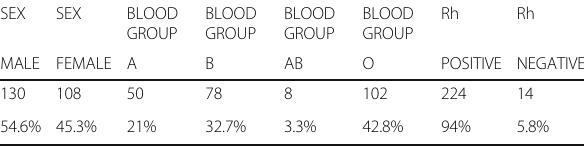
Table 1 (abstract 0184). ABO and Rh blood group distribution in dengue disease (Sex: p=0.873, blood group: p=0.043, Rh p=0.497)